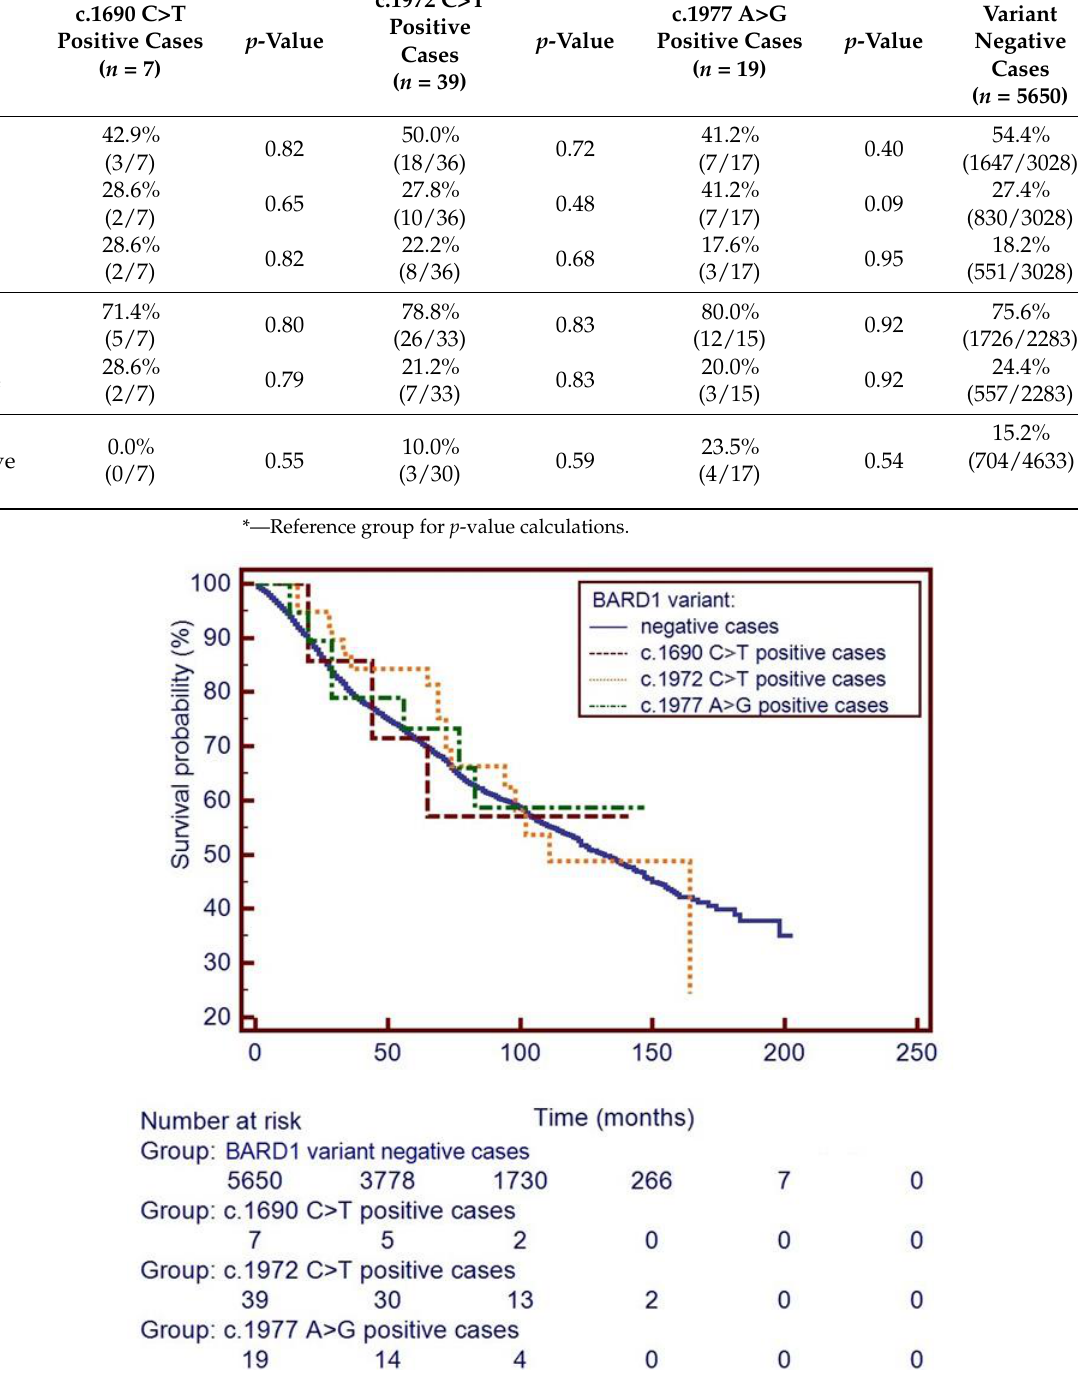
Figure 1. Survival curves of men with prostate cancer and a BARD1 variant (7 patients with c.1690C>T, 39 patients with c.1972C>T and 19 men with c.1977A>G) and of BARD1 variant negative prostate cancer patients (5650 non-carriers). Footnote to Figure 1: BARD1 variant negative prostate cancer patients –prostate cancer patients negative for c.1690 C>T, c.1972 C>T and c.1977 A>G variants of BARD1